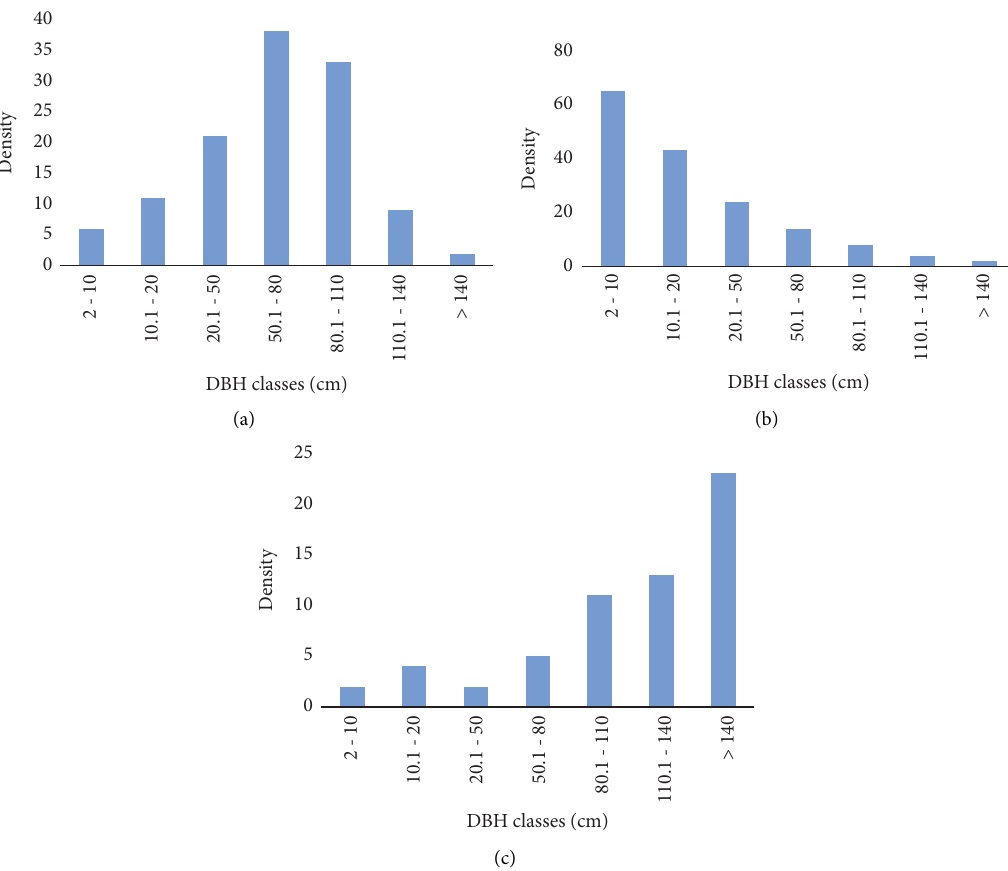
Figure 3: (a–c) Representative patterns of species population structure in Abbo Sacred